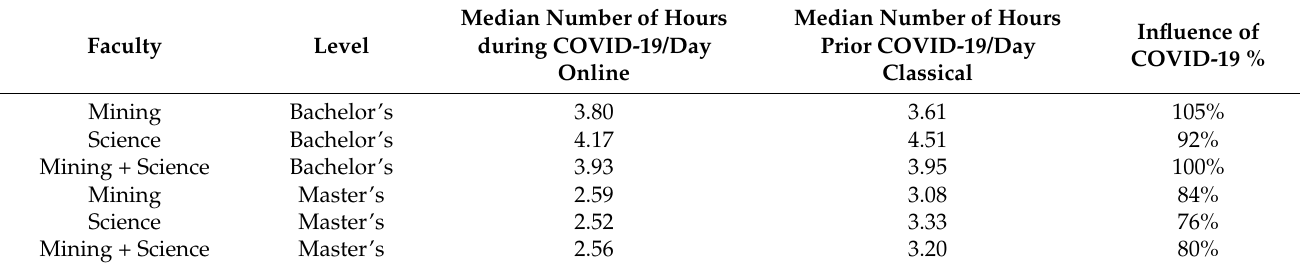
Table 15. Comparison between median number of classes held during COVID-19 and